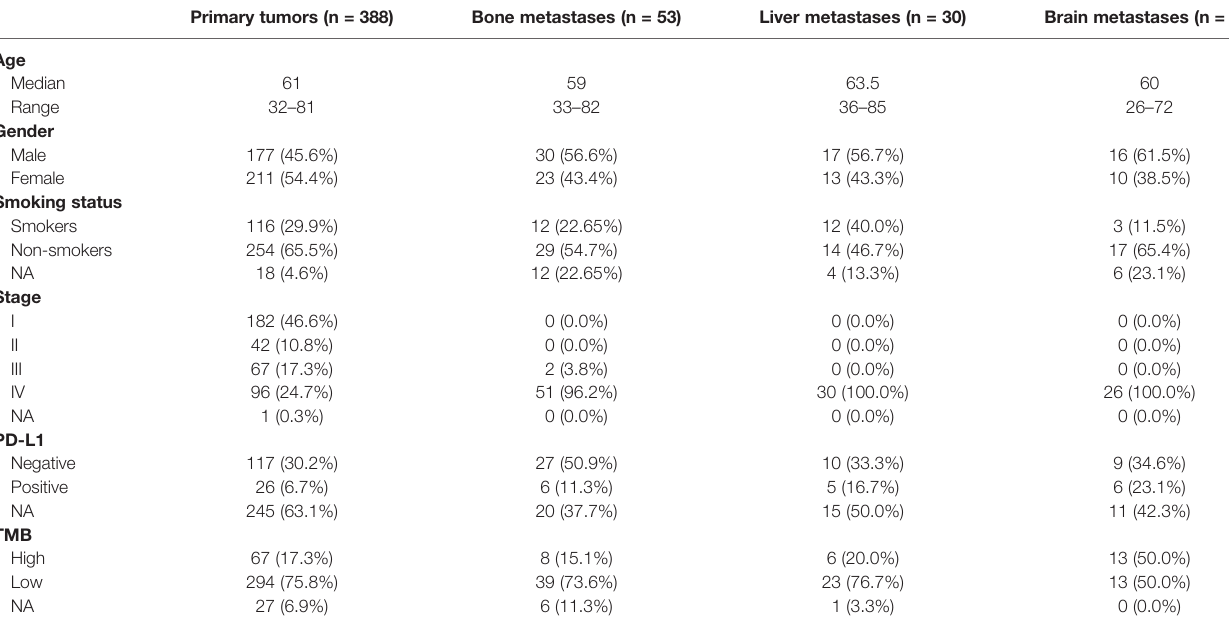
TABLE 1 | Clinicopathological pro fi le of